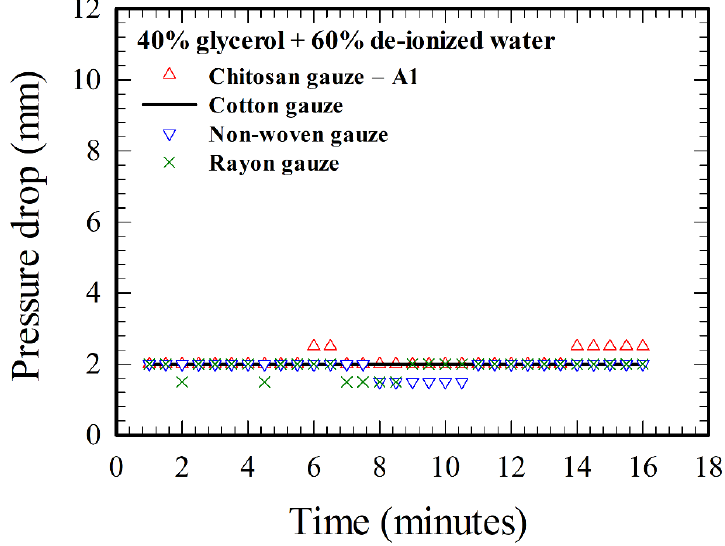
Figure 2. Time evolution of the pressure drops across various gauzes for glycerol–water solution.